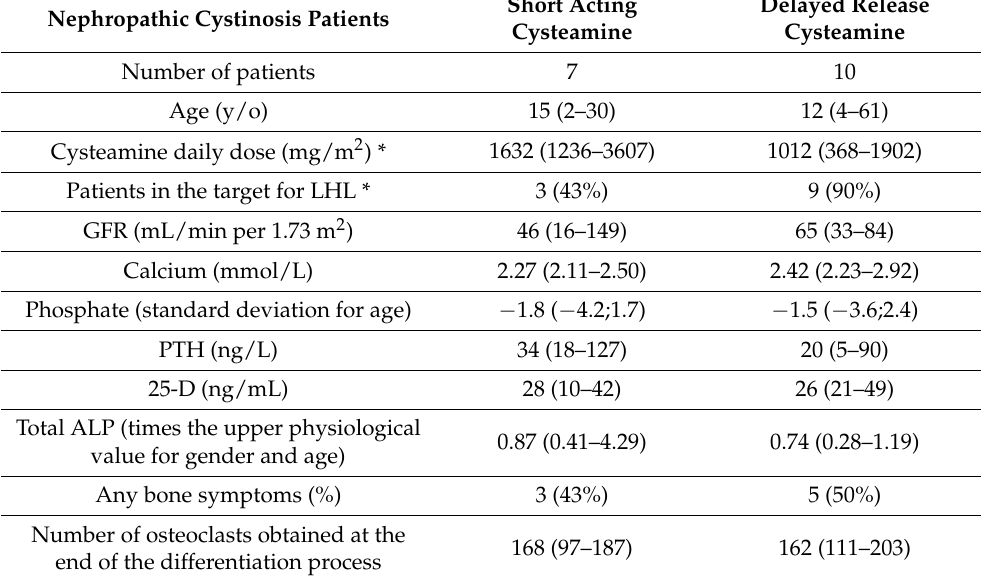
Table 2. Patients’ characteristics according to the type of cysteamine.